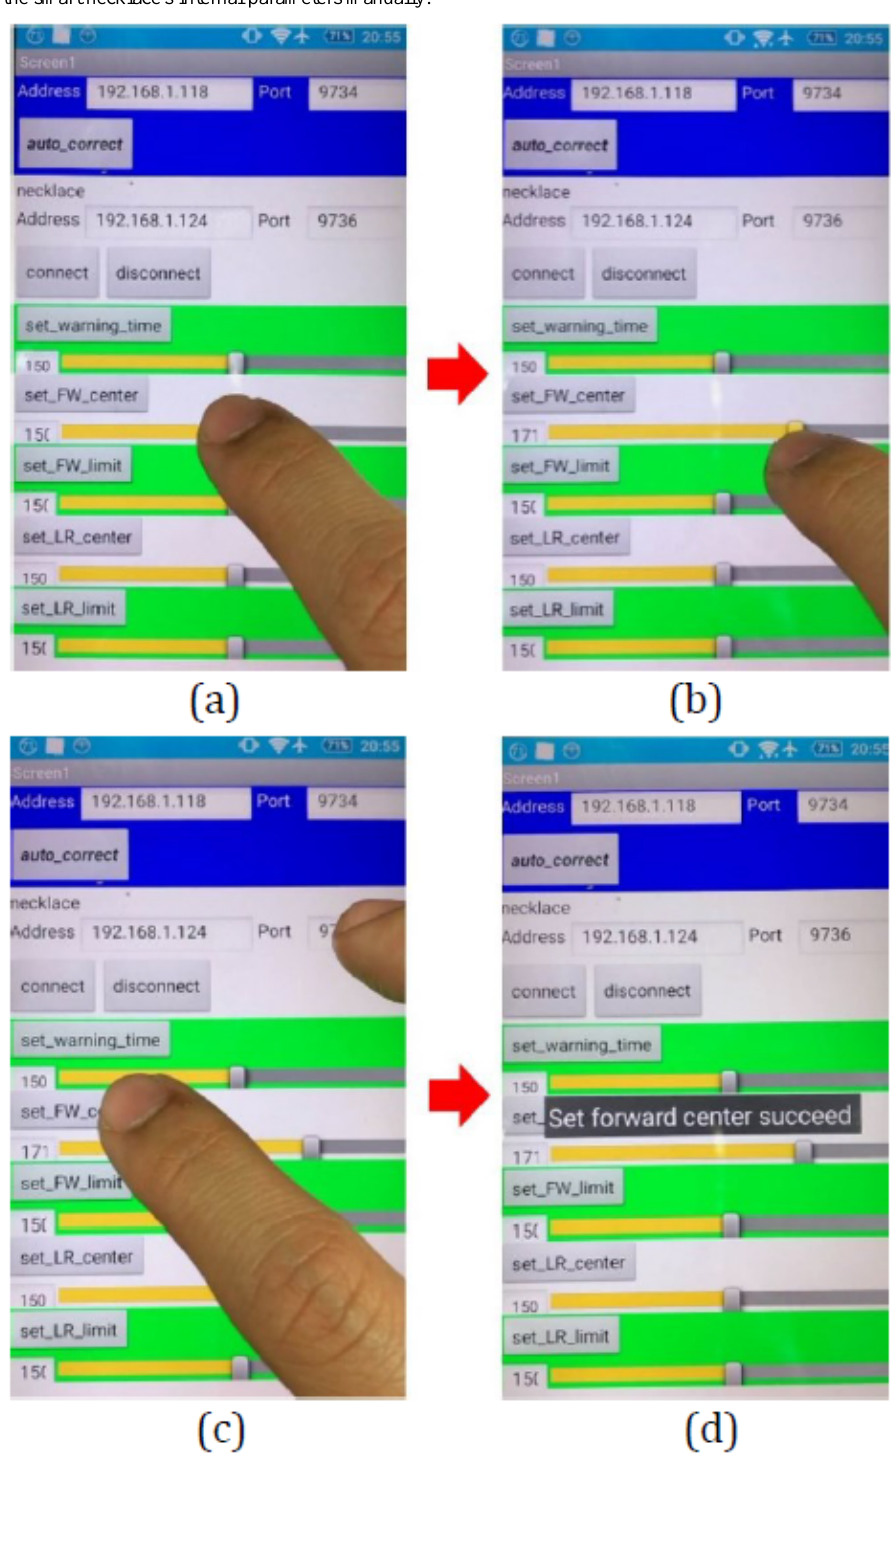
Figure 18. Setting of the smart necklace's internal parameters